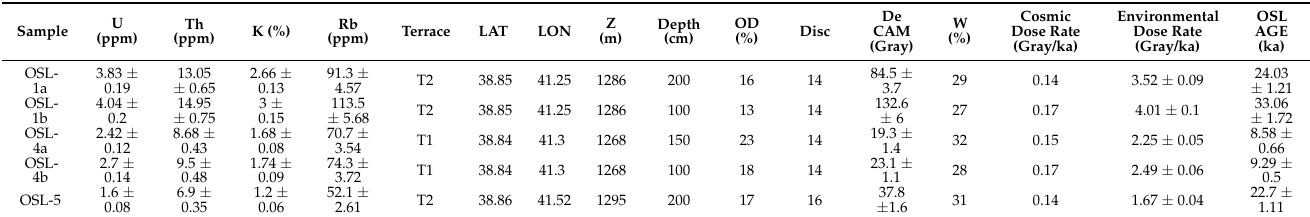
Table 2. Details of concentrations of the radioactive elements used for environmental dose rate estimations and age estimates for the